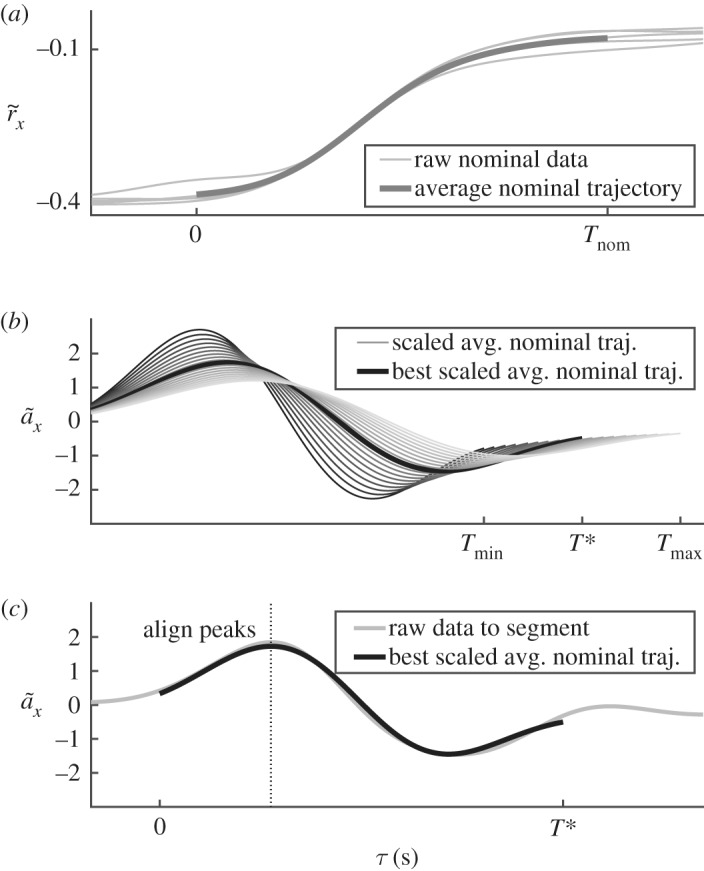
This figure illustrates the segmentation procedure. Step 2(b) of the procedure is depicted in (a). We take the subject’s five nominal trials, shown in light grey, and average them to form a single average nominal trajectory, shown as the thick darker grey line. We choose a start and end time [0,Tnom] for the average nominal trajectory as in Step 2(d). Step 3(a–b) of the procedure is depicted in (b). We obtain the horizontal acceleration trajectory of the average nominal trajectory by twice differentiating the position trajectory shown in (a). We then iterate over time scales in [Tmin,Tmax], scaling the trajectory according to §2.2.2. These scaled trajectories are shown in shades of grey. An example trajectory corresponding to time T* is shown as the thick black line. Step 3(c–e) of the procedure is depicted in (c). The horizontal acceleration trajectory of a trial to be segmented is shown as the thin light grey line. Of the scaled trajectories in (b), the one corresponding to time T*, shown as the thick black line, matches the best. The start and end times of the trial to be segmented are then determined by the endpoints of the overlaid black line.